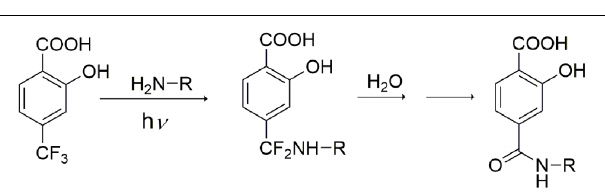
SCHEME 1 | Proposed mechanism of HTB-ubiquitin adduct